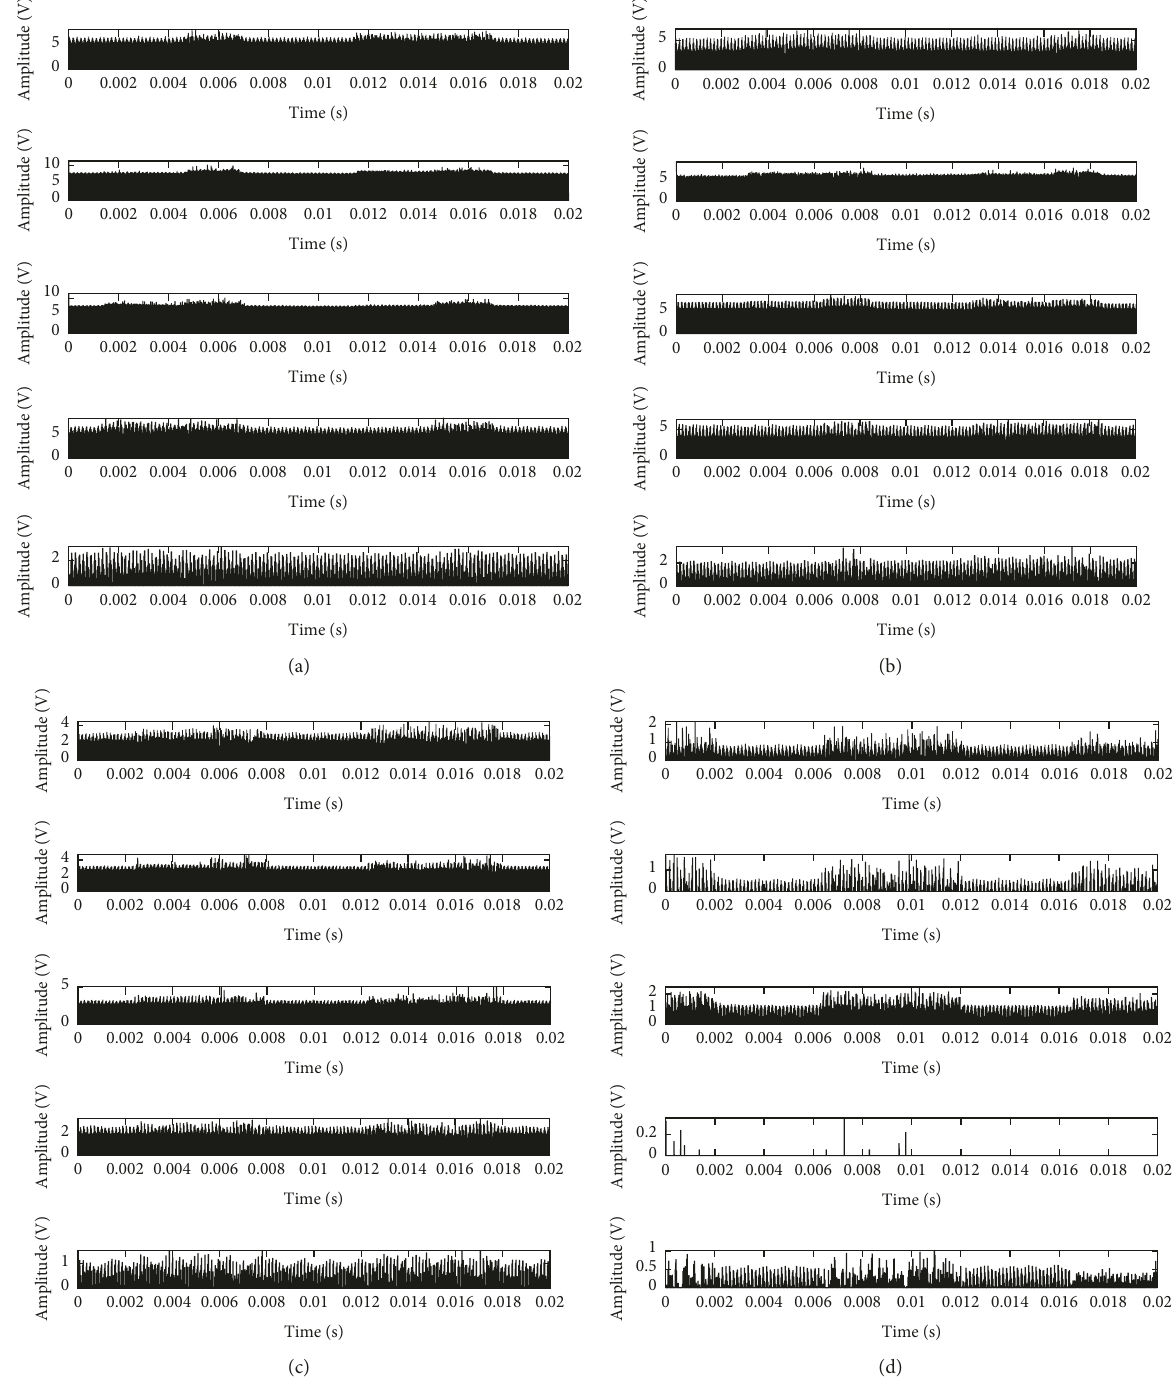
Figure 5: The MMS components of the standard data in four degradation states: (a) normal state; (b) slight degradation; (c) severe degradation; (d) failure